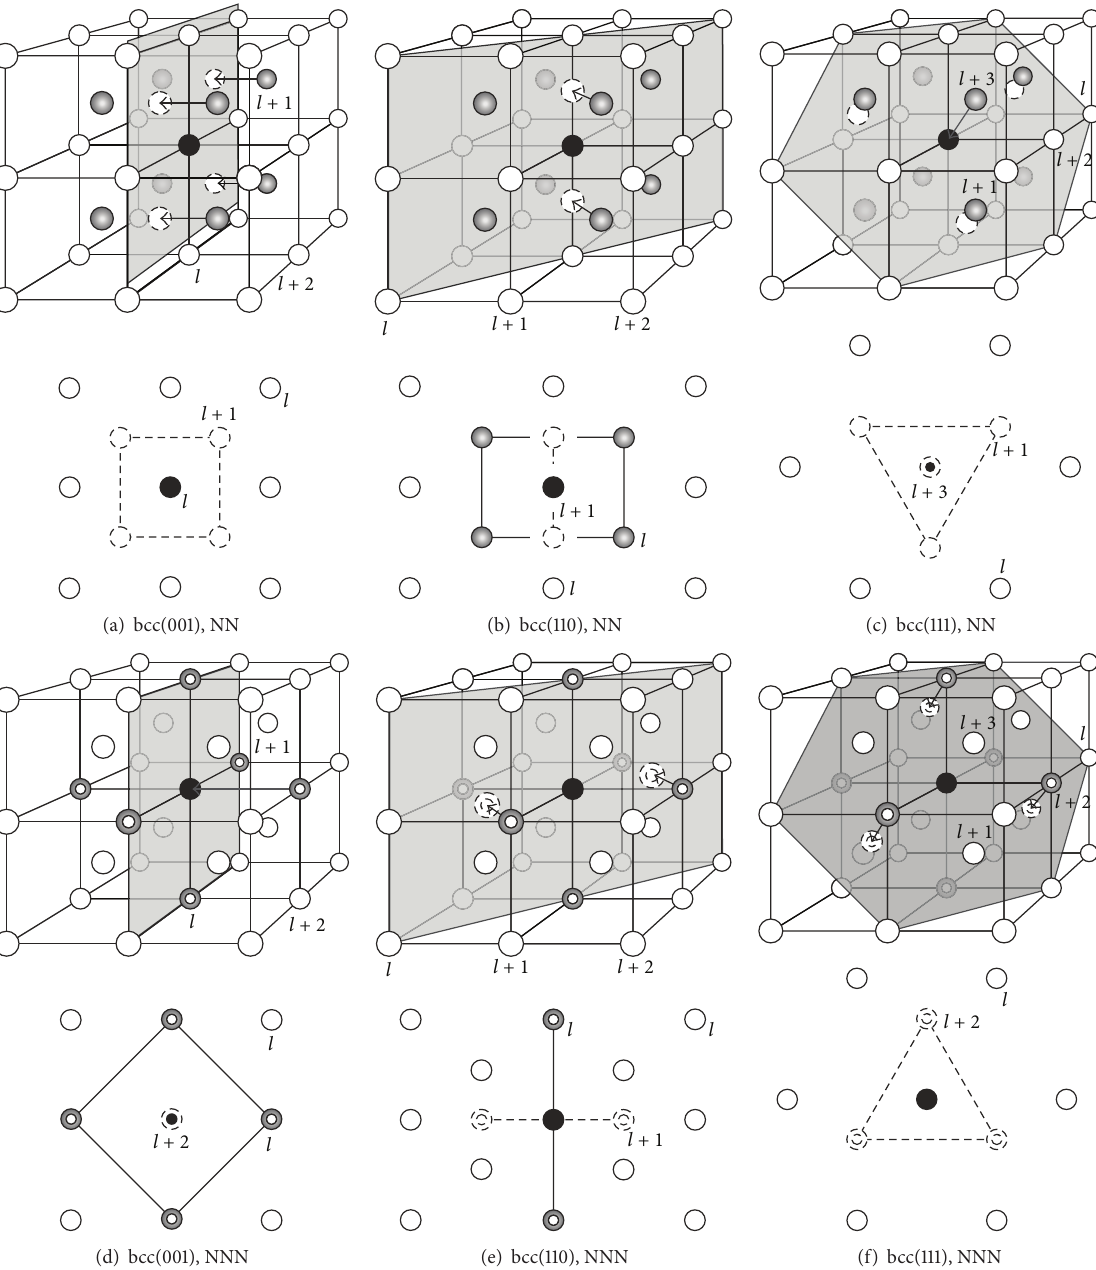
Figure 11: The same distribution and mapping of neighbors as in Figure 10 but for bcc thin